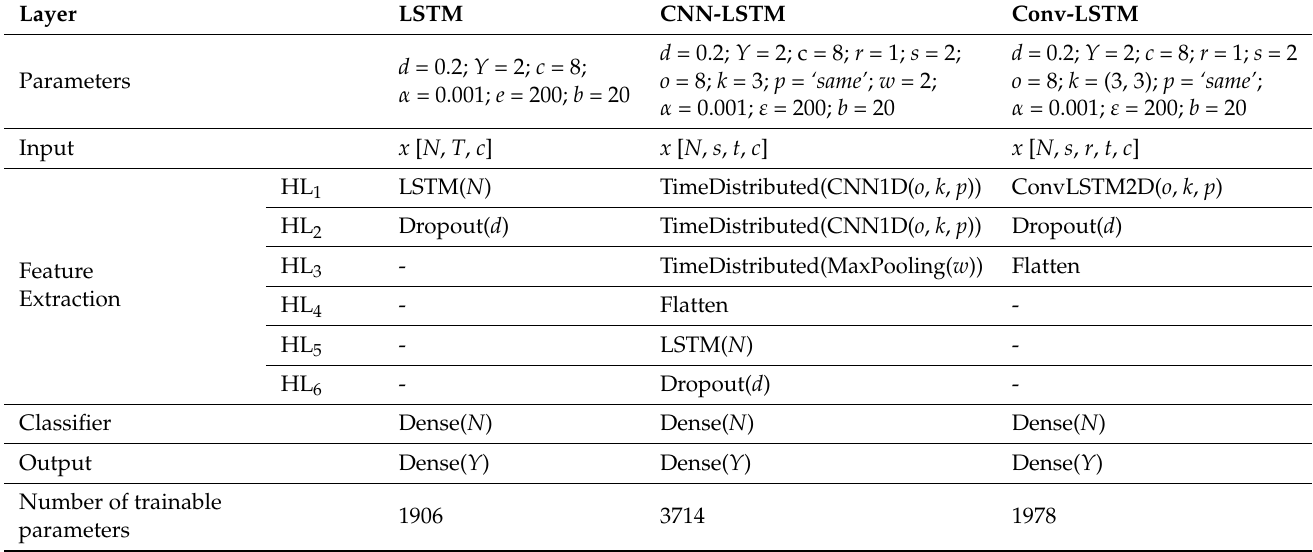
Table 1. An overview of the proposed LSTM, CNN-LSTM, and Conv-LSTM architectures provide an early prediction system for at-risk